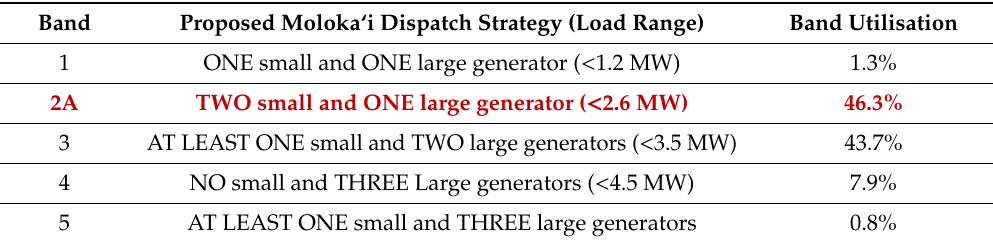
AT LEAST ONE small and THREE large generators Table 6. Moloka‘i diesel utilisation for a 3 MW solar PV scenario (low-load dispatch scheme).